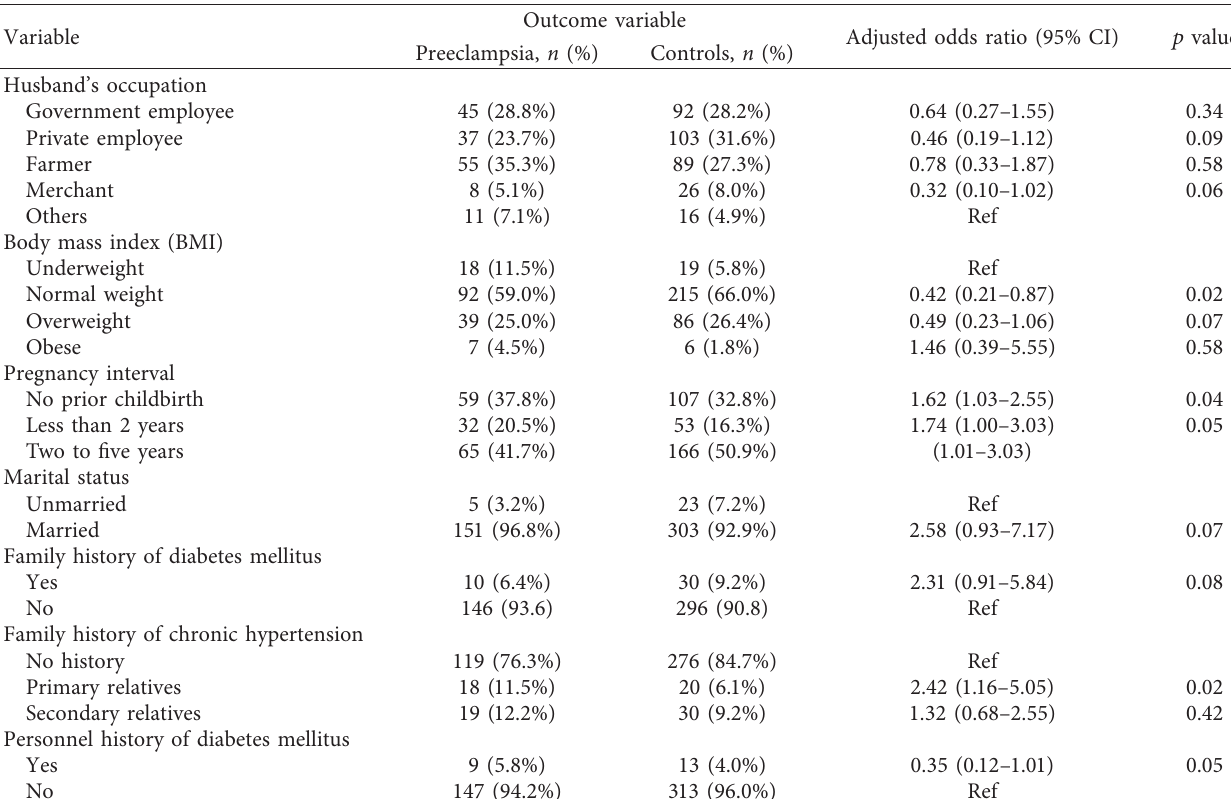
Table 4: Multivariable output for a case-control study on personnel and obstetric factors of preeclampsia among pregnant women attending hospitals in southern